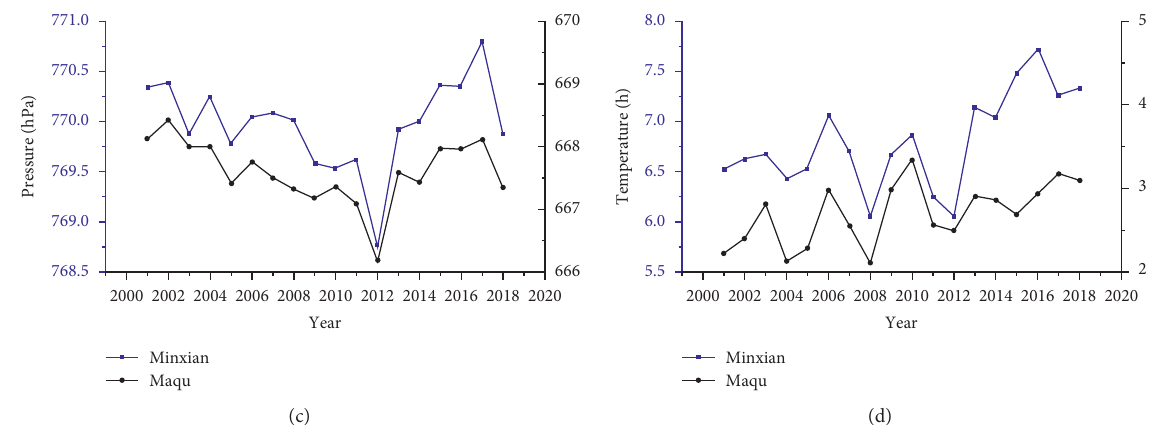
Figure 14: Changes of main climatic factors in Maqu and Minxian stations over the upper Taohe River basin from 2001 to